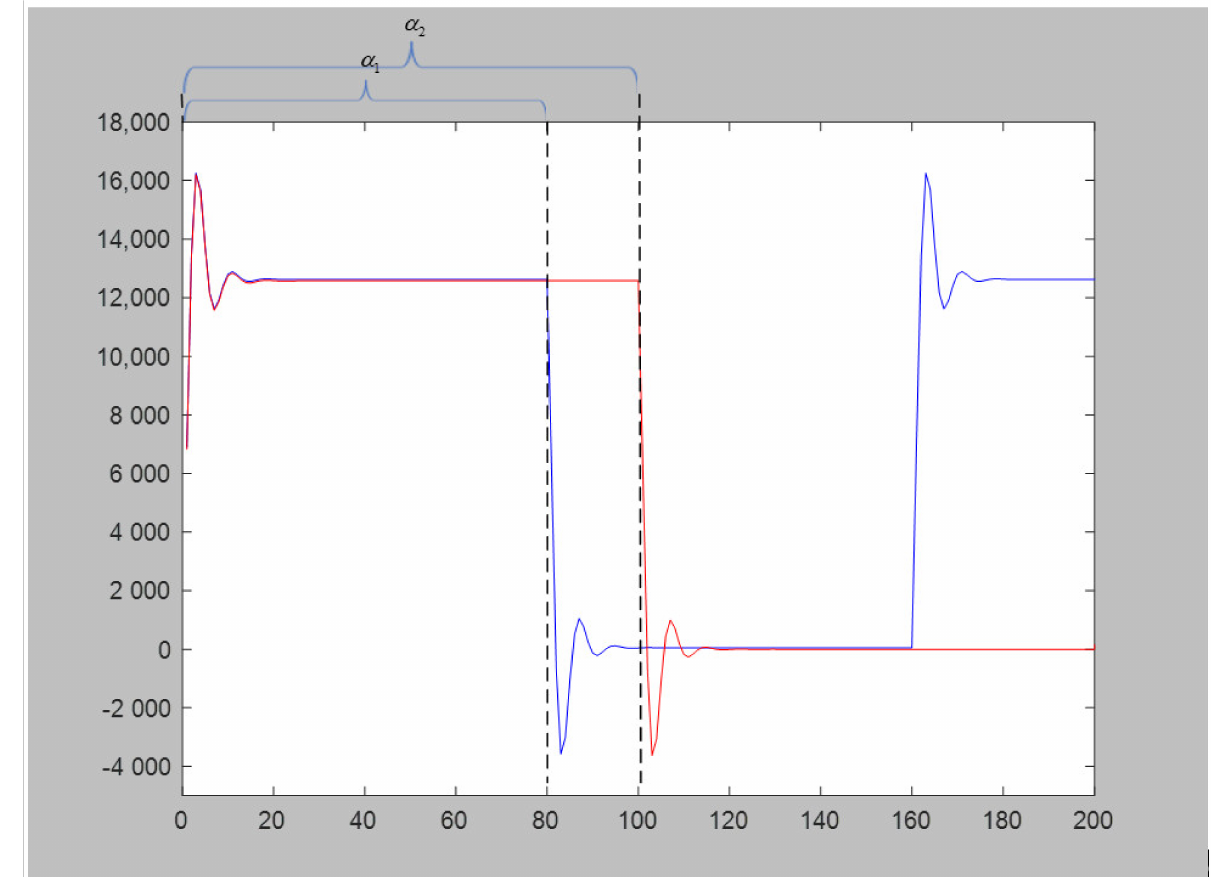
Figure 15. Baseband signal after passing through the power amplifier.